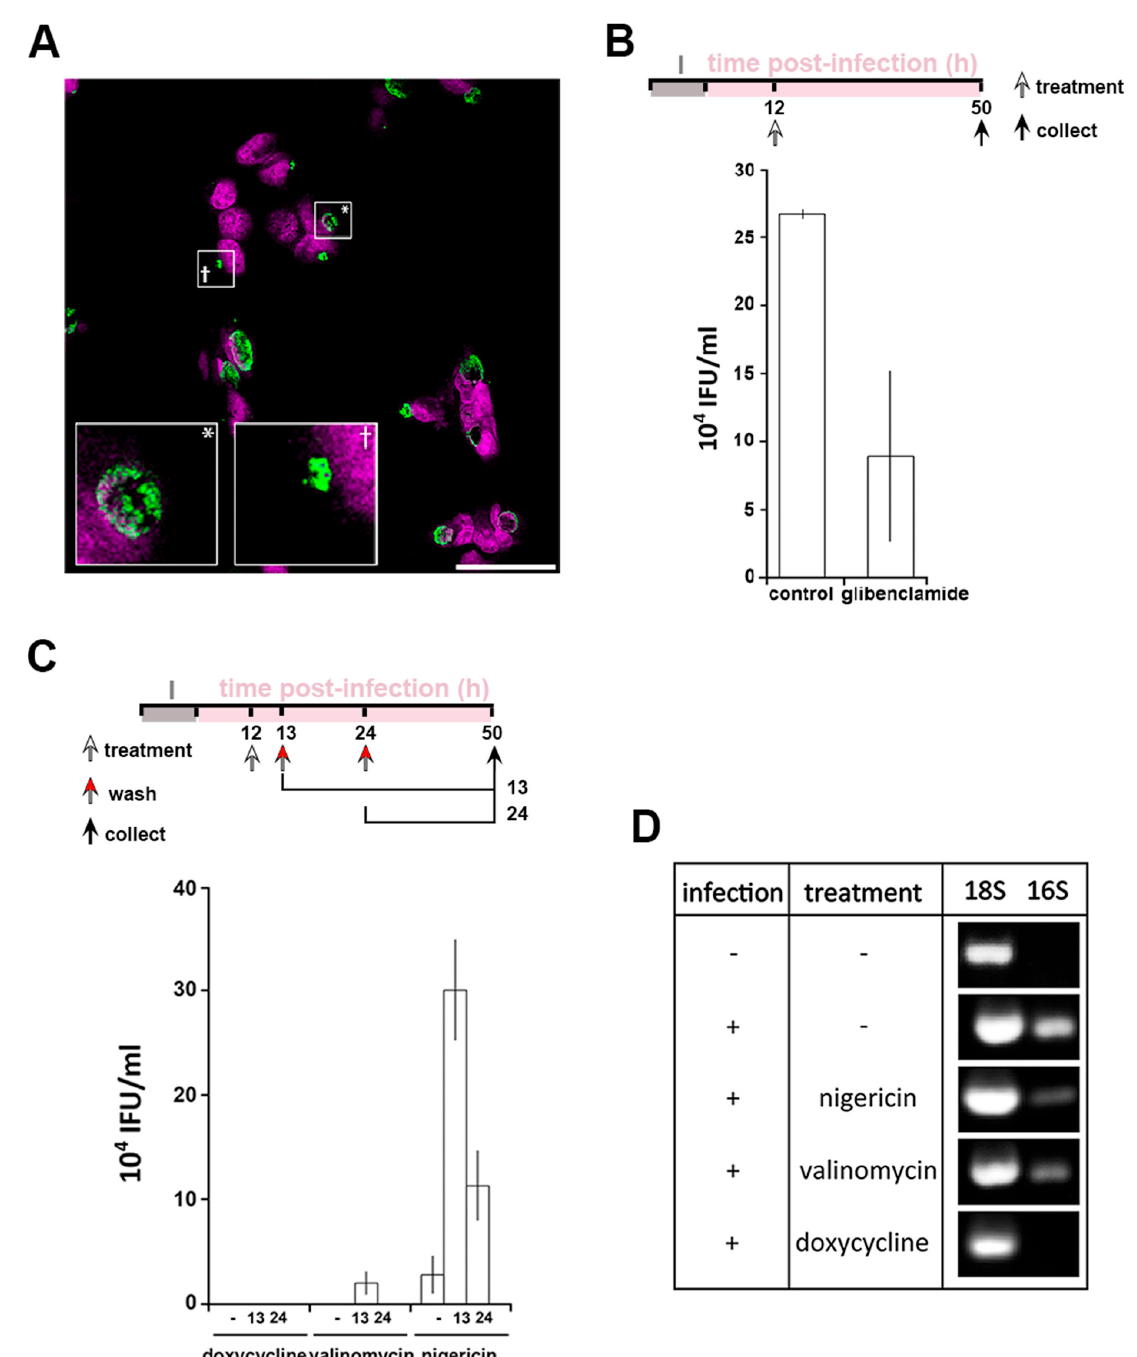
Figure 4. Interfering with cytoplasmic [K + ] leads to Chlamydia persistence. HeLa cells were infected with C. trachomatis LGV2. ( A ) Cells were treated with glibenclamide 12 hpi prior to fixation at 24 hpi followed by labelling with anti- Chlamydia (green) and DNA probe (DRAQ-5, magenta). Insert shows a normal inclusion (*) and abnormal inclusion (+) at higher magnification. Scale bar: 25 µ m. ( B ) upper panel: schematic of the experiment design. I: infection. Lower panel: after treatment with glibenclamide and sample collection as described in the upper panel, lysate were tested for infectivity by measuring inclusion forming units per mL (IFU/mL). ( C ) Upper panel: schematic of the experiment design. I: infection. Lower panel: reversion of persistence assay, performed as described in the upper panel. Infectivity assays were performed (IFU/mL: inclusion forming unit per mL). For ( B ) and ( C ), error bars: standard deviation. ( D ) At 12 hpi, cells were treated with 1 µM nigericin, valinomycin or doxycycline. At 50 hpi, cells were prepared for RNA expression analysis by RT-PCR using 18S as a loading control and 16S as a marker of bacterial viability.